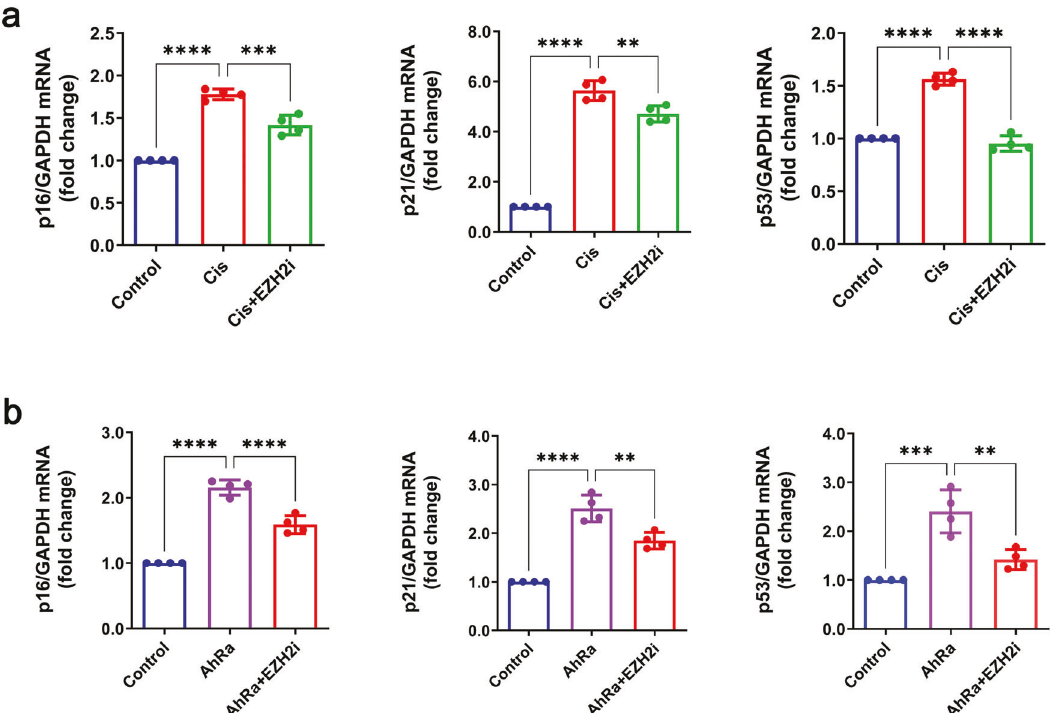
Fig. 8 Effects of EZH2 inhibition on AhR agonism-mediated tubular epithelial TCMK-1 cell senescence. a The mRNA level of senescence related p16, p21, and p53 in cisplatin-induced AKI with or without EZH2 inhibitor zld1039 (EZH2i, n = 4). b The mRNA level of senescence related p16, p21 and p53 in AhR activation (AhRa) by FICZ with zld1039 ( n = 4). Data are represented as means ± SDs. cis, cisplatin. **** P < 0.0001, *** P < 0.001, ** p < 0.01, * p <